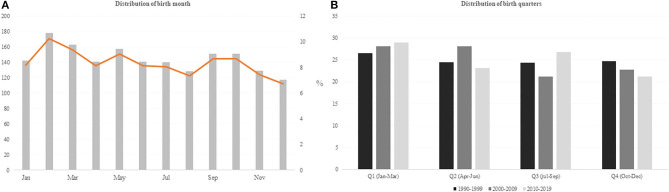
Distribution of (A) birth months (left) and (B) birth quarters according to the decades of the NBA draft (right).